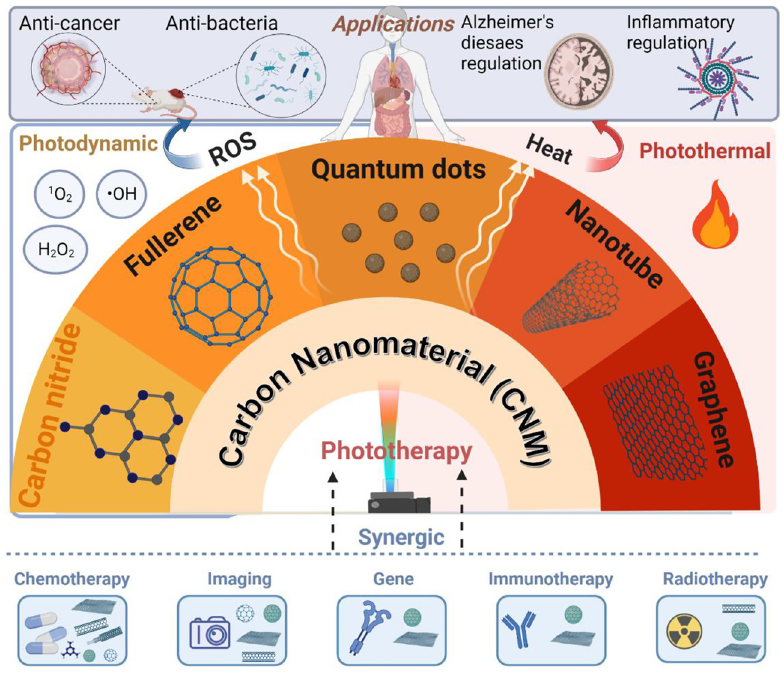
Figure 2: Summary of carbon nanomaterials (CNMs)forphototherapy,createdwithBioRen-